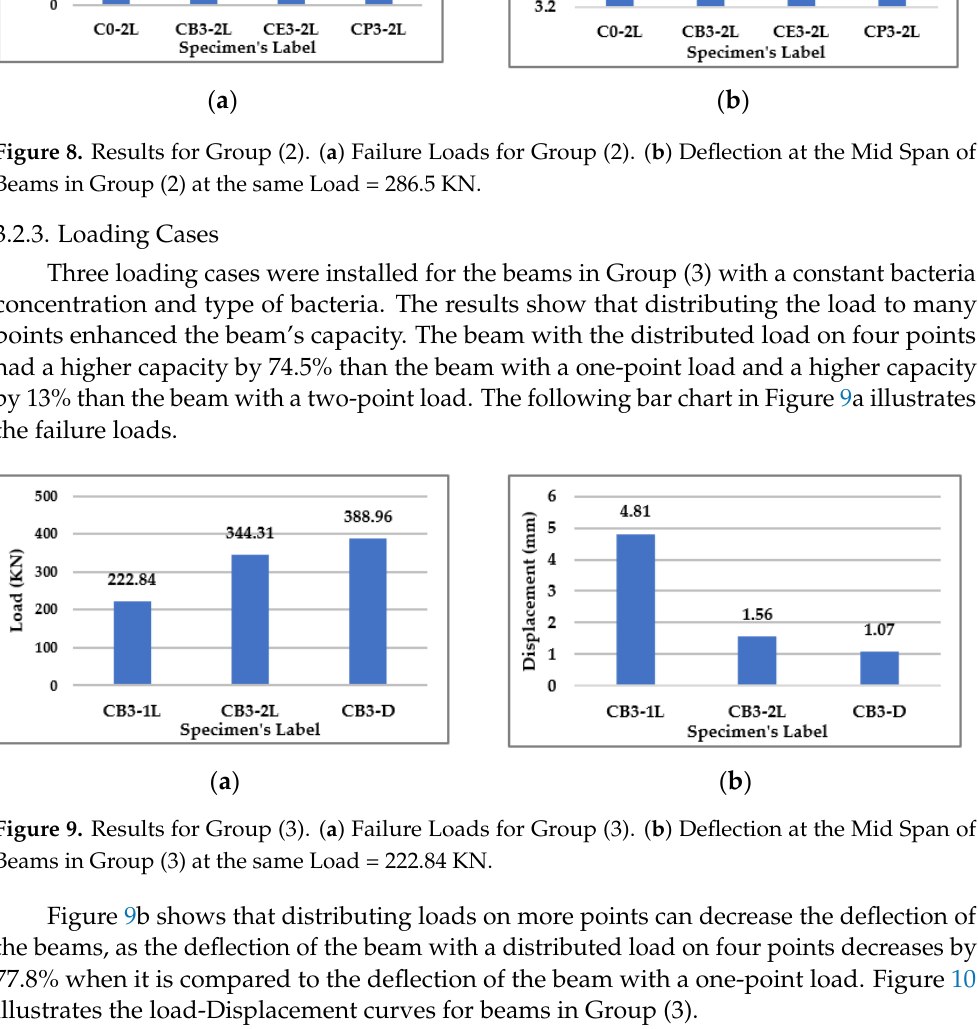
Figure 9. Results for Group (3). ( a ) Failure Loads for Group (3). ( b ) Deflection at the Mid Span of Beams in Group (3) at the same Load = 222.84 KN.